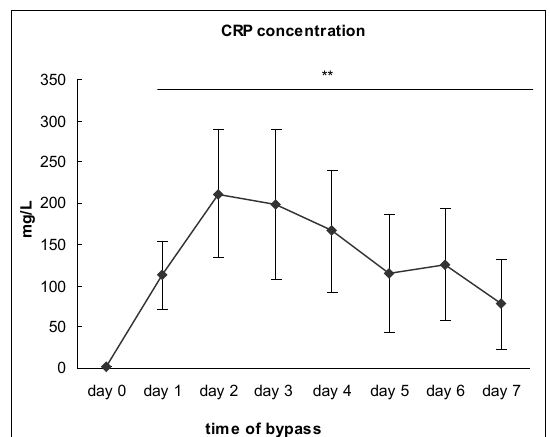
Figure 4. Changes in CRP levels before and after CABG. Statistical significance: within-group comparison with baseline: ** p <